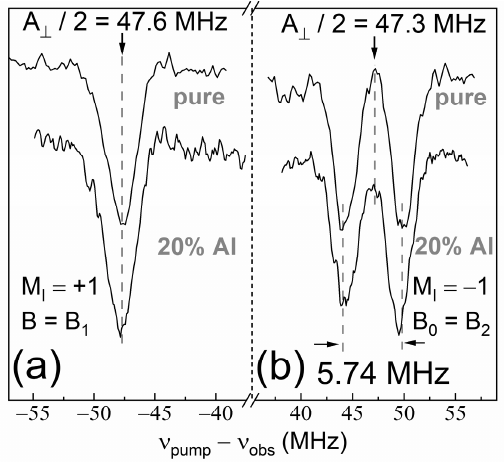
Figure 4. EDNMR spectra for the single quantum transition according to the quantum number M I: ( a ) M I = +1 at B 0 = B 1 , ( b ) M I = − 1 at B 0 = B 2 (see Figure Table 3. Quantitative values of quadrupole interaction, depending on the external magnetic field values.